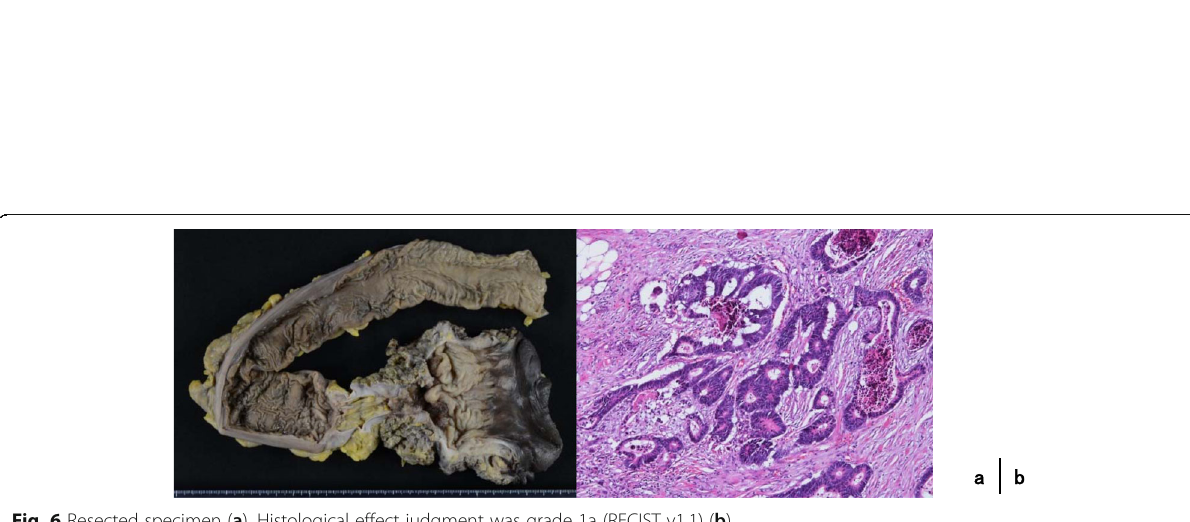
Fig. 6 Resected specimen ( a ). Histological effect judgment was grade 1a (RECIST v1.1) ( b )